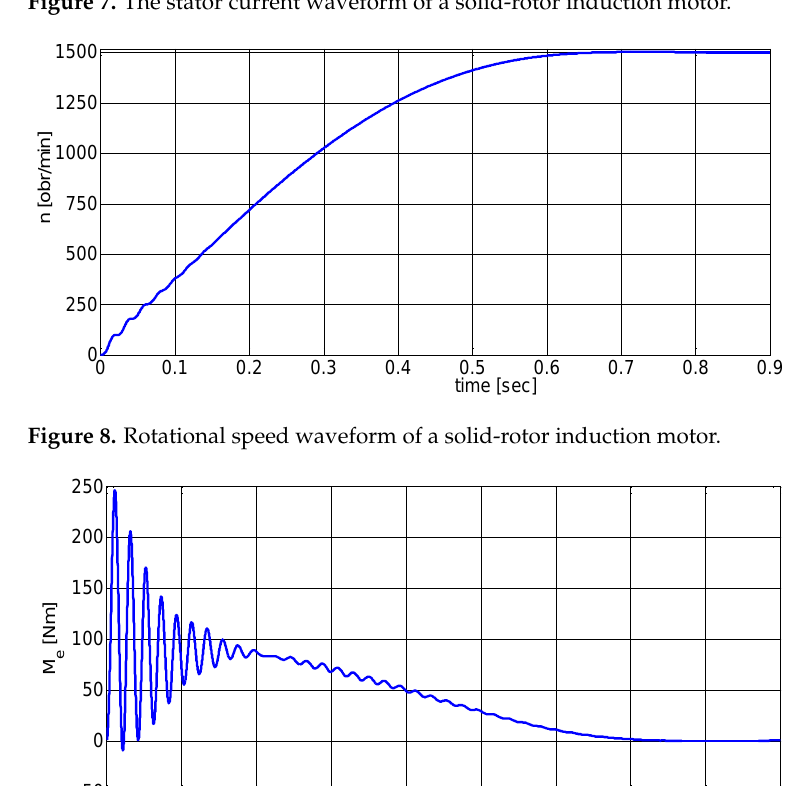
Figure 7. The stator current waveform of a solid-rotor induction motor.